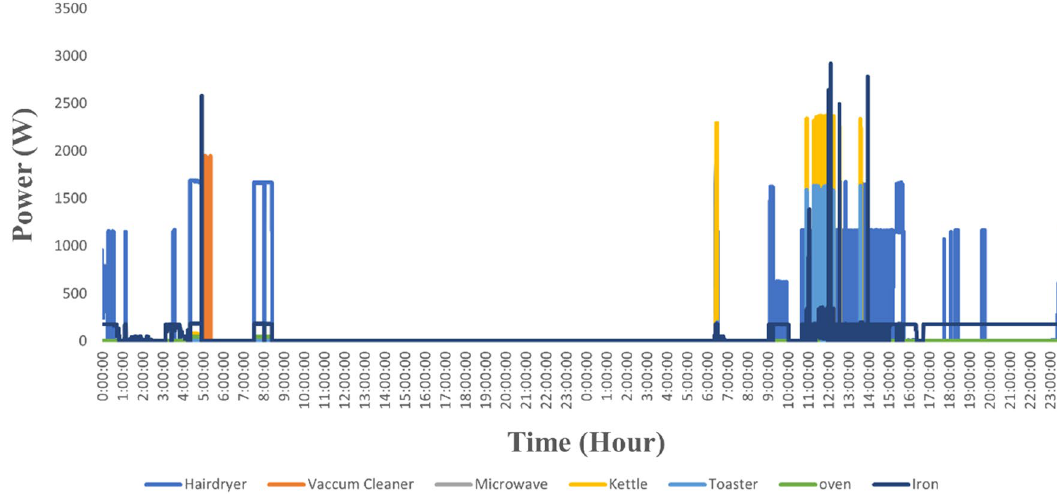
Figure 7. Extracted profile of individual appliance.